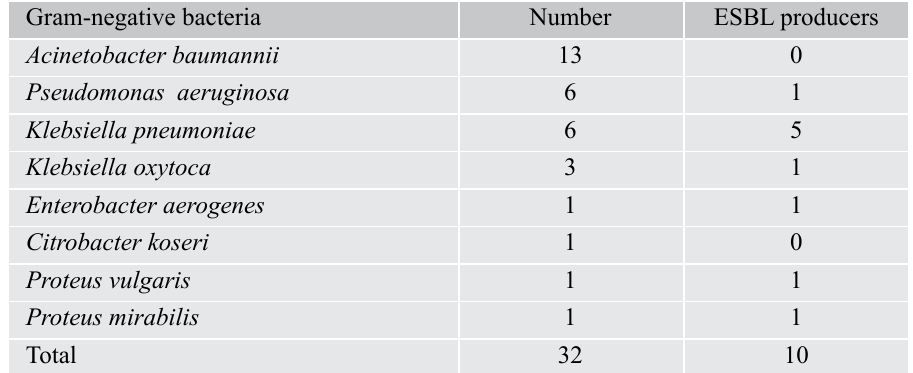
Table IV: Distribution of ESBL producing gram-negative bacteria identified by DDS